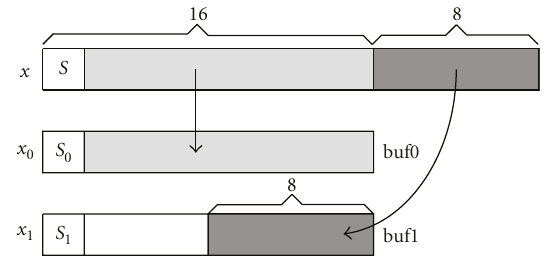
Figure 4: The standard storage data